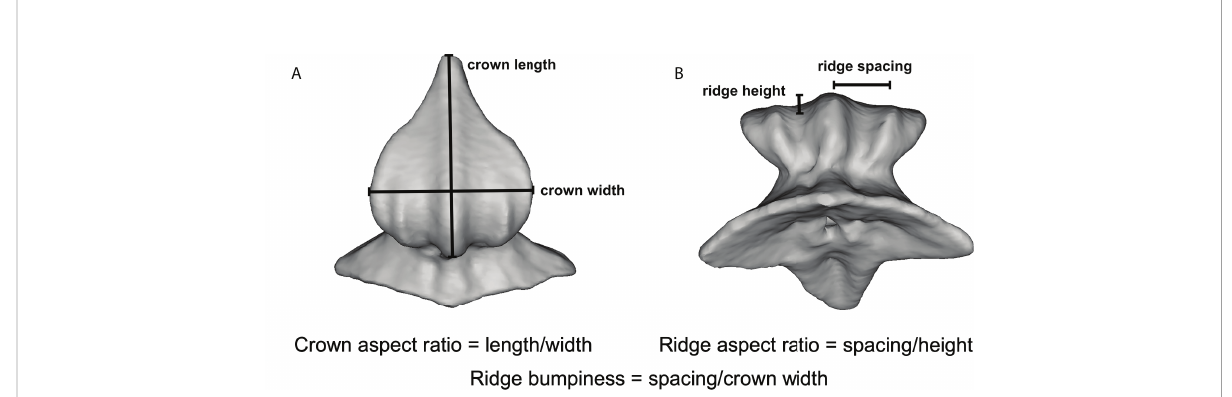
FIGURE 1 µCT images showing denticle and ridge measurements from a single leopard shark ( Triakis semifasciata ) denticle. (A) Dorsal view of denticle showing crown length and width measurements, and (B) view of the anterior denticle surface showing measured ridge height and spacing. De fi nitions of other calculated variables (i.e., crown aspect ratio, ridge aspect ratio, and ridge bumpiness) are given in the